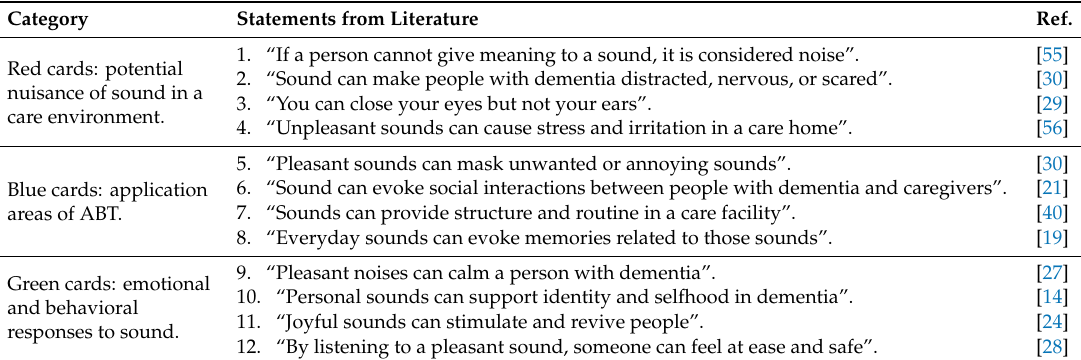
Table 1. The cards contained statements and conclusions of relevant academic research to inform the professional caregivers of the opportunities and challenges of audio-based technology (ABT) for dementia care. Category Statements from Literature Ref.